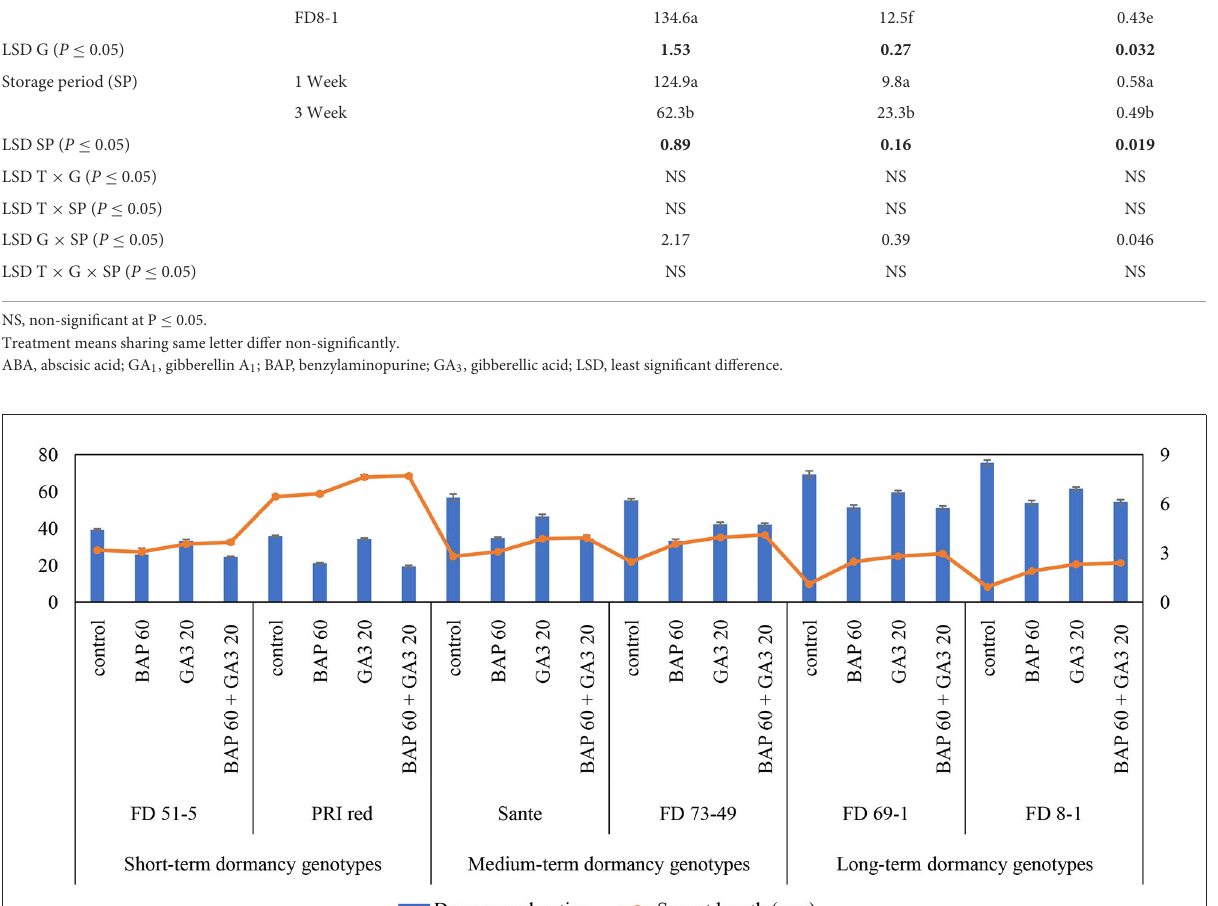
dormancy and ABA levels. The short-term dormancy genotypes (PRI Red and FD51-5) had significantly lower levels of ABA than the medium-term (FD73-49 and Sante) and long-term